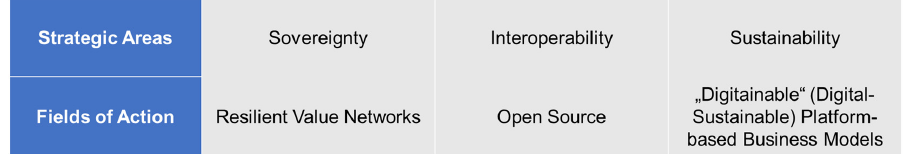
Figure 1. Strategic Areas [8] and Promising Fields of Action for Industrie 4.0 (Own